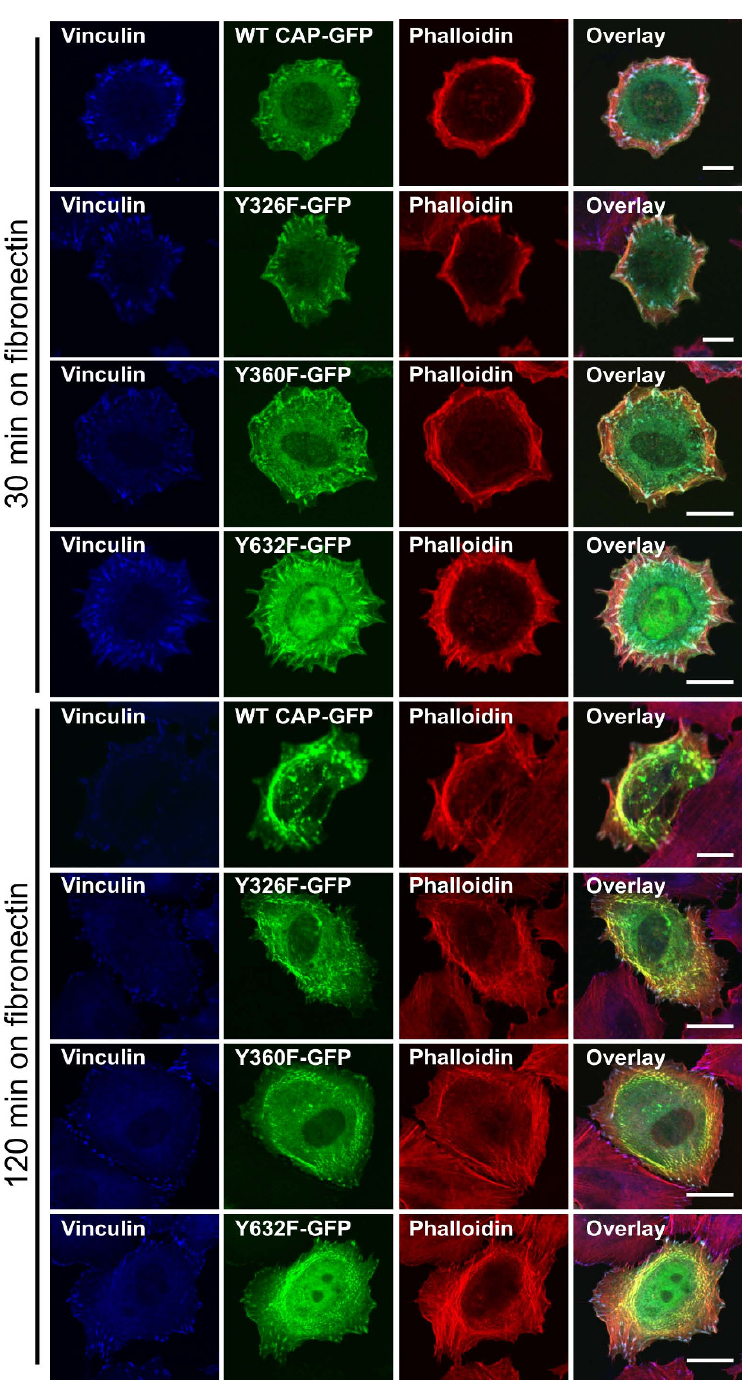
Figure 4 Tyrosine mutations do not alter the localization of CAP into focal adhesions and stress fibers . Cells transfected with CAP-EGFP, Y326F, Y360F or Y632F mutant were seeded out on fibronectin coated coverslips, allowed to adhere for 30 min or 120 min, fixed and stained for vinculin (blue) and phalloidin (red). WT CAP, Y326F and Y360F mutant were found to show a similar overall localization, whereas Y632F mutant exhibited some nuclear staining, in addition to focal adhesions and stress fibers. All CAP variants showed two localization patterns, either colocalizing with vinculin in cell matrix adhesions after shorter spreading times (30 min) or with actin fibers after longer times of spreading (120